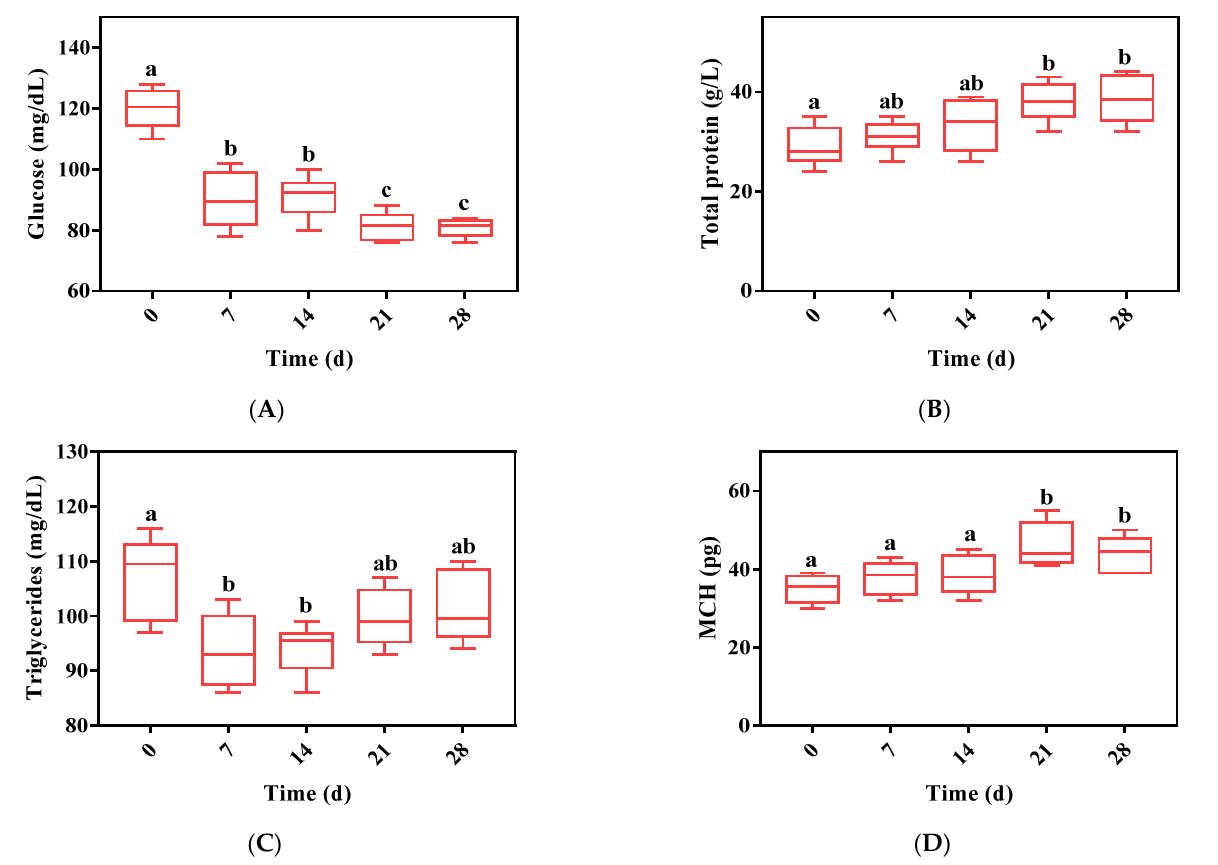
Figure 6. Blood biochemical levels of crucian carp at different sampling times. ( A ) Glucose (mg/dL); ( B ). Total protein (g/L); ( C ) Triglycerides (mg/dL); ( D ) MCH (pg). The results are expressed as mean ± SD ( n = 6), and different letters indicate significant differences between groups ( p < 0.05).